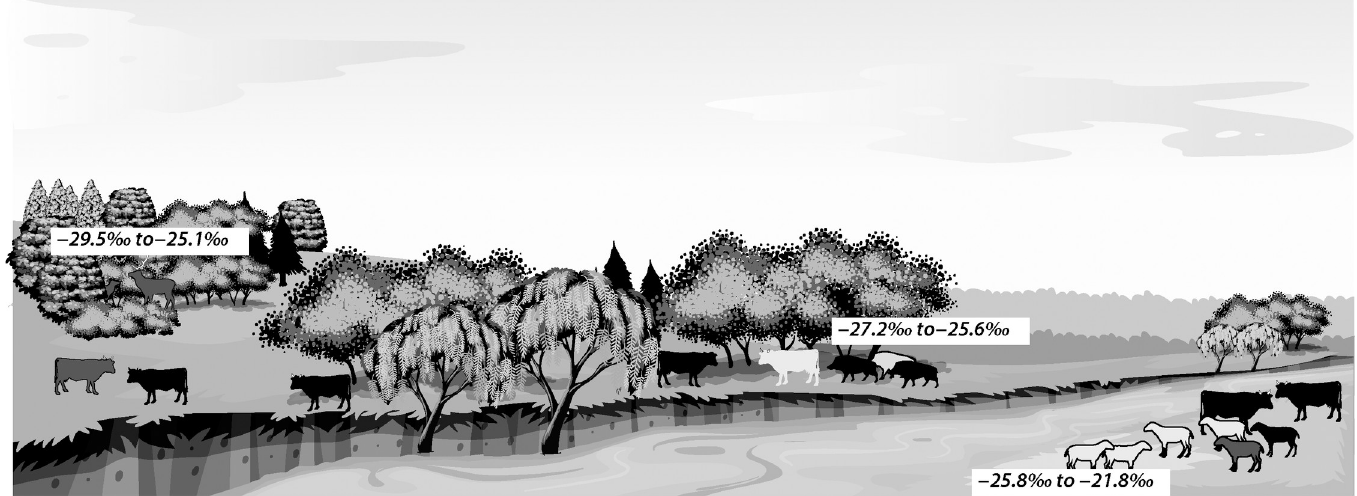
Fig 6. Illustration of the isotopic variation between ecosystems with the vicinity of Vin č a-Belo brdo. The δ 13 C values indicate (from left to right): Deer and domesticated pigs sampled as part of this study, and Suess effected adjusted values for halophyte plants [92] to illustrate the gradient from dense to light forest canopies and salt marshes. The base images were made available on the ‘Nature scenes with fields’ https://www.vecteezy.com/vector-art/605564-nature-scenes-with-fields-and- mountians licensed to RG. The animal silhouettes are available under CC 4.0 from ArcheoZoo.org.